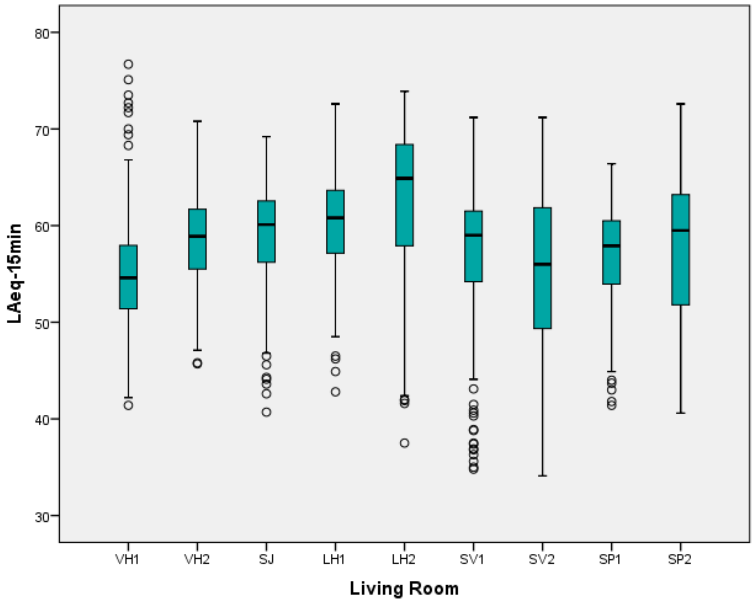
Figure 8. Distributions of L Aeq-15min scores as a function of the living rooms.